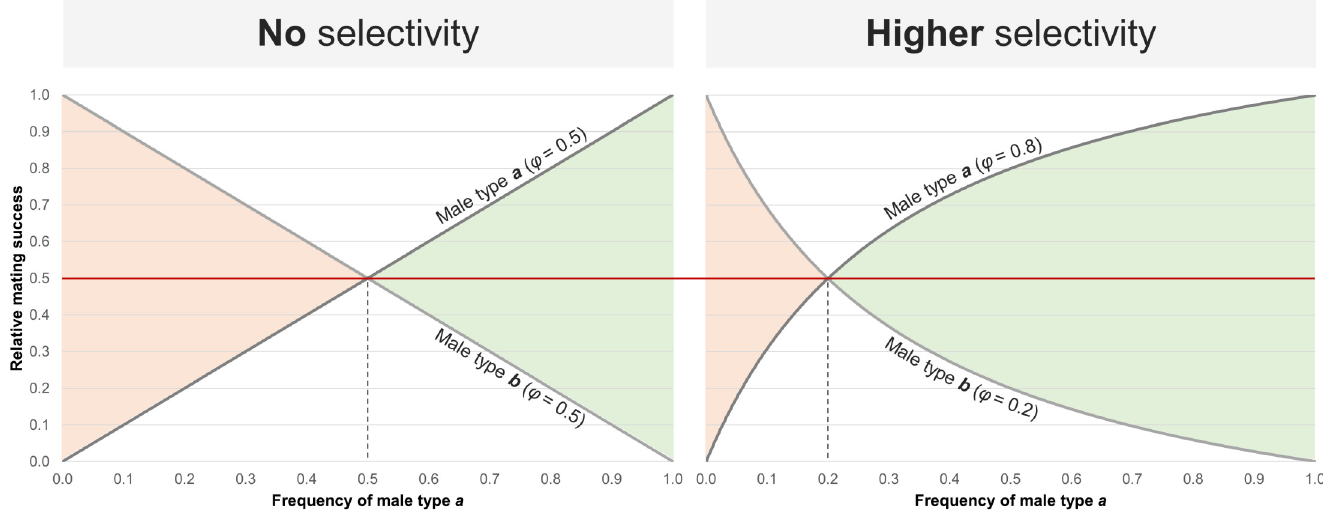
Fig 2. Relative mating success of two theoretical male types as a function of their frequency and female preference ( φ ). The intersection between both lines bounds two areas: the red area, in which male type b has a higher relative mating success, and the green area, in which male type a has a higher relative mating success. If female preference is similar towards both male types ( φ = 0.5; i.e. females choosing male type a or male type b for mating is equally probable), the male relative mating success depends exclusively on their frequency in the population (assuming that the effect of all other synergistic factors affecting male mating success are similar for both male types). However, if females show a higher preference for a particular male type (e.g. φ = 0.8 for male type a ), the frequency-based functions of the male relative mating success deviate, increasing the green area and decreasing the red area, that is, increasing the relative mating success for male type a and decreasing it for male type b .